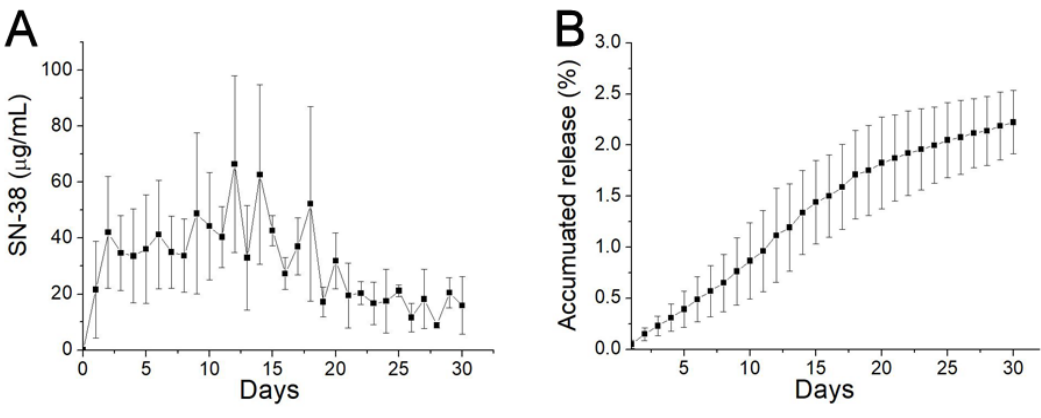
Figure 4. In vitro release. ( A ) Daily release; and ( B ) accumulative release of 7-ethyl-10-hydroxycamptothecia (SN-38) from biodegradable SMPs.